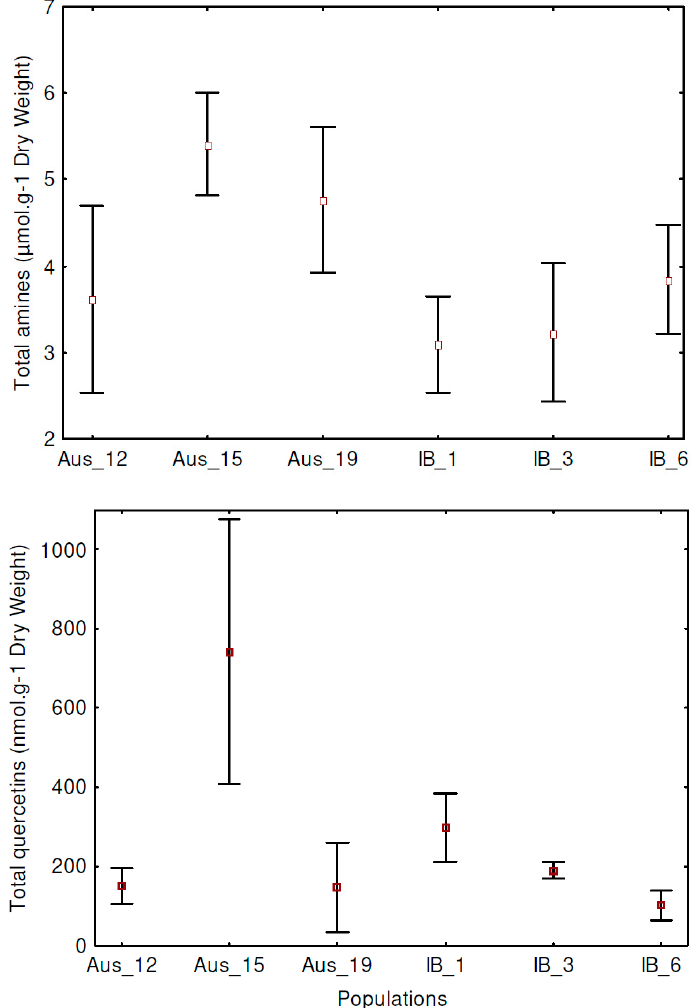
Figure 1. Variance of total contents of amines or quercetins among populations. Means and SD (standard deviation) are given. See Table 1 for test statistics.